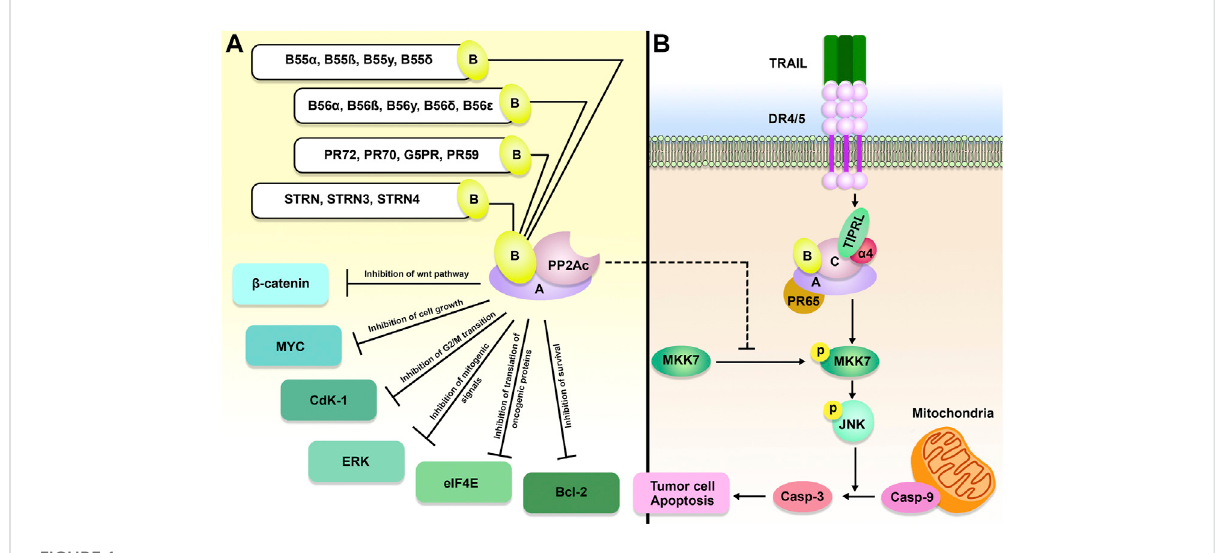
FIGURE 1 TIPRL/PP2A axis and TOR signaling pathway. Active PP2A holoenzyme is an important inhibitor of the TOR signaling pathway. Besides, PP2A inhibits cancer cell growth and survival through dephosphorylation of 4E-binding protein 1 4EBP-1) and S6 kinase (S6K). PP2A holoenzymes can be inhibited as a result of α 4/TIPRL-mediated recycling and disassembly of scaffold (A) and regulatory (B)